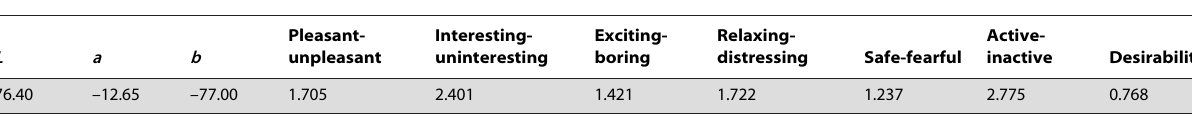
Table 4. The optimal solution for color design.